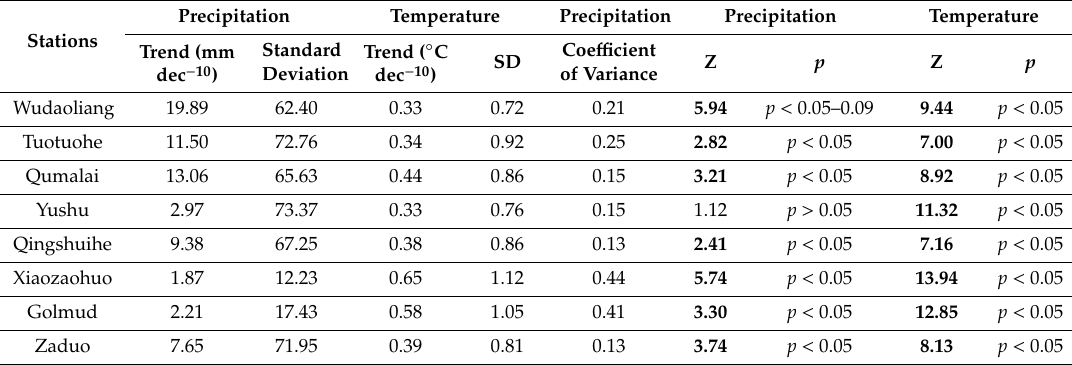
Table 3. Linear trends in precipitation and temperature and modified Mann–Kendall statistics (Z) during 1961–2015. Bold values show statistically significant trends at a 0.05 significant